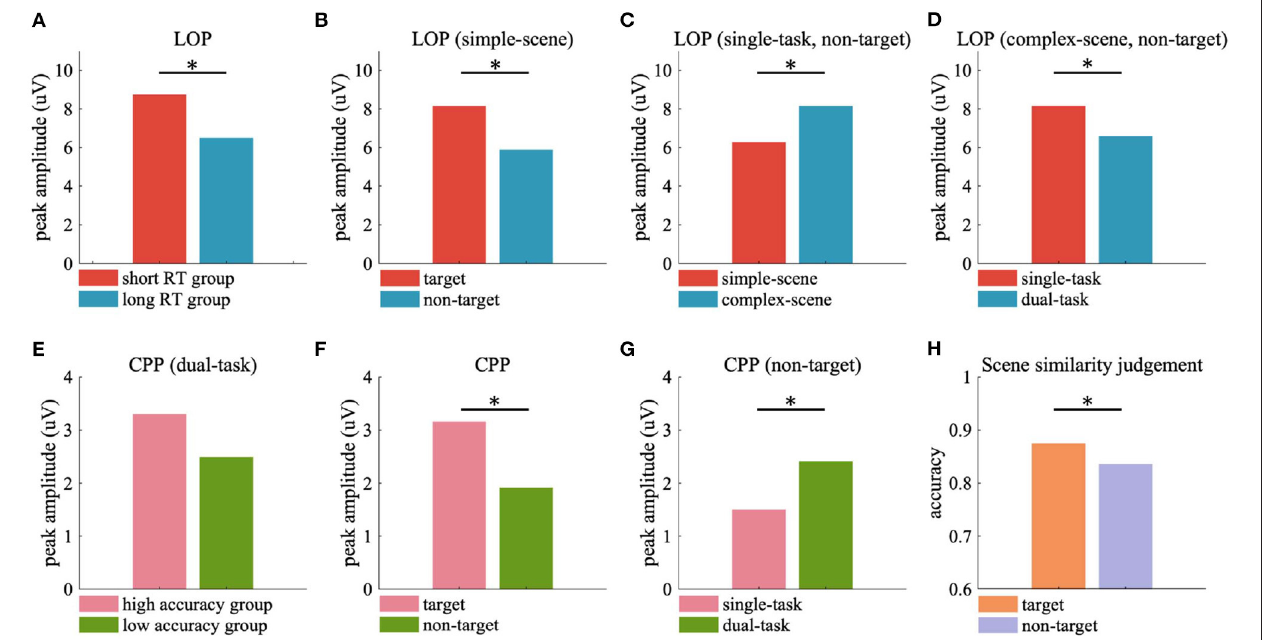
FIGURE 9 | Peak ERP responses and scene similarity judgement accuracy averaged over participants. (A) Peak LOP amplitude of short RT and long RT groups. (B–D) Peak LOP amplitude evoked by target and non-target in simple-scene (B) , simple-scene and complex-scene without target in single-task (C) , single-task and dual-task in complex-scene without target (D) . (E) Peak CPP amplitude of high accuracy and low accuracy groups. (F) Peak CPP amplitude evoked by target and non-target. (G) Peak CPP amplitude evoked by non-target in single-task and dual-task. (H) Accuracy of scene similarity judgement for stimuli with target and without target. Significant differences are indicated by black stars ( p < 0.05, two-sample t